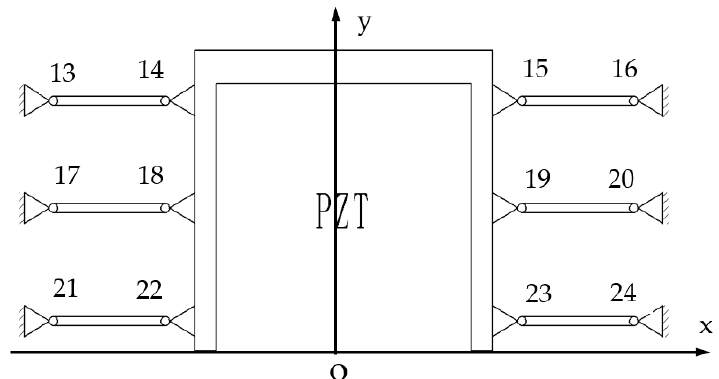
Figure 4. Principle diagram of the balanced additional force.